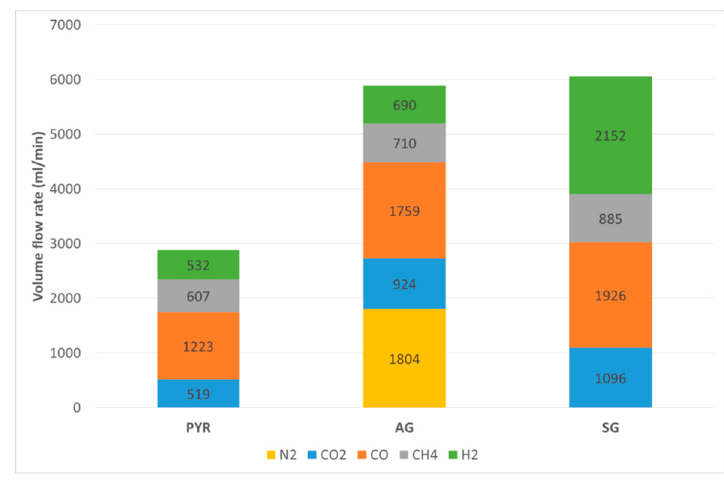
Figure 4. Volume flow rate (in ml/min) of syngas compounds.